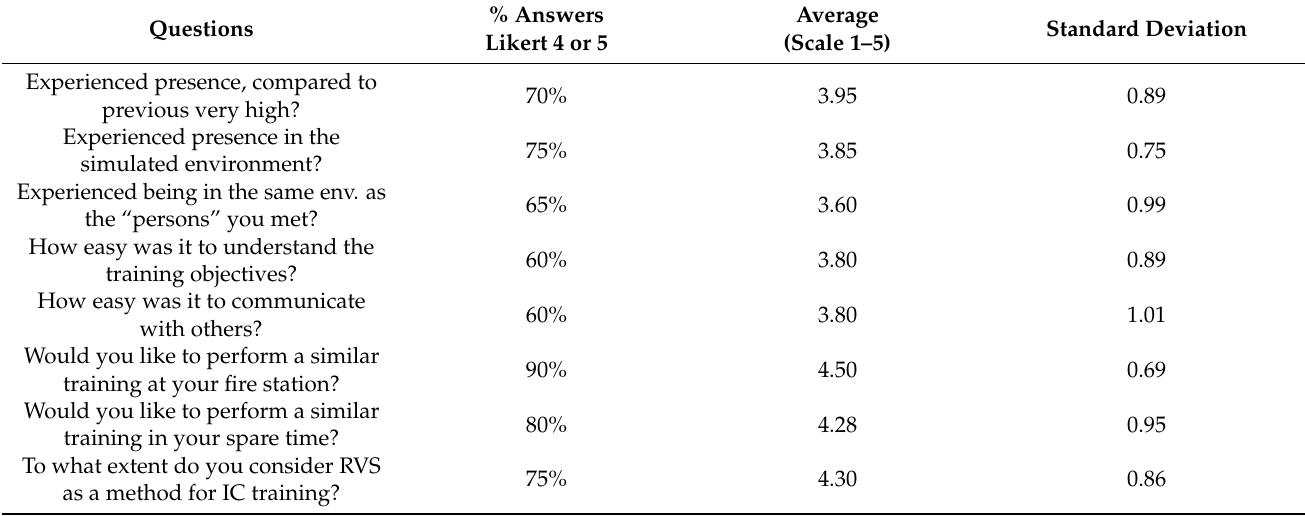
Table 4. Students’ response ( n = 20) to the RVS examination. Answers in Likert scale, 1 (low) to 5 (very